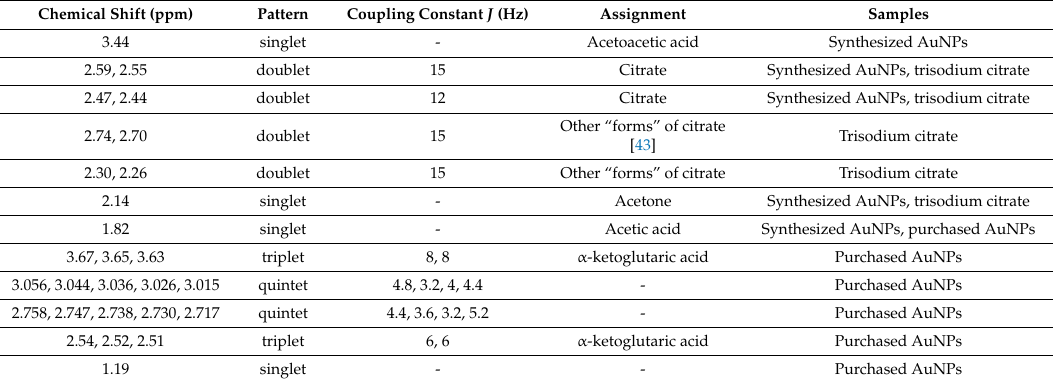
Table 1. 1 H-NMR data for synthesized, purchased AuNPs and trisodium citrate. Chemical Shift